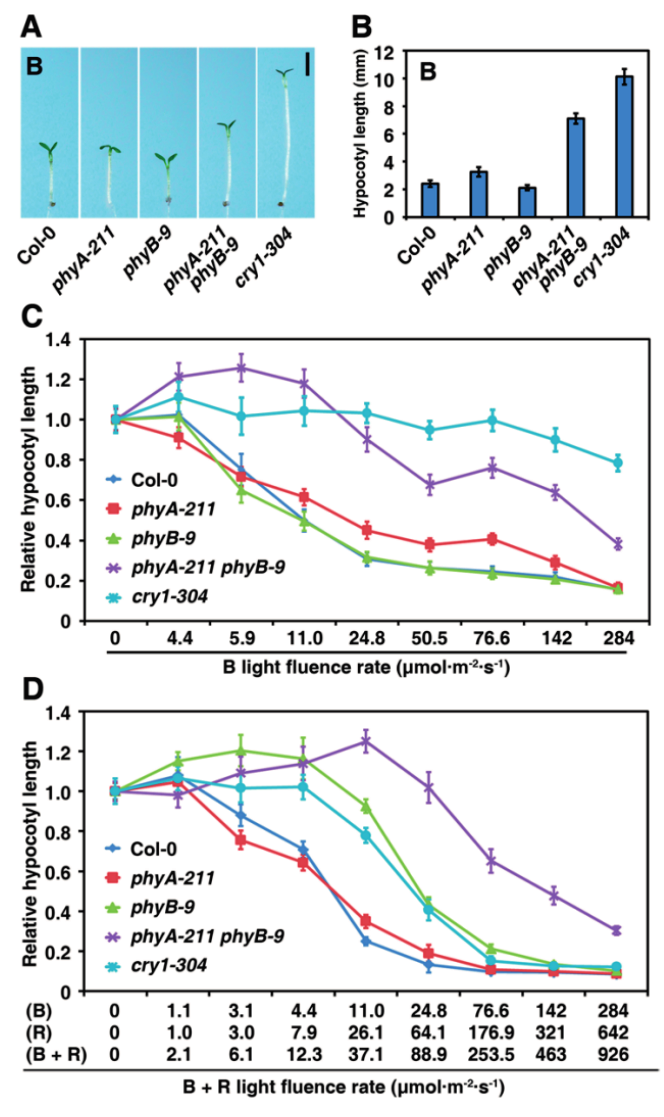
Figure 2. PhyA and phyB synergistically repress hypocotyl elongation under blue ( B )